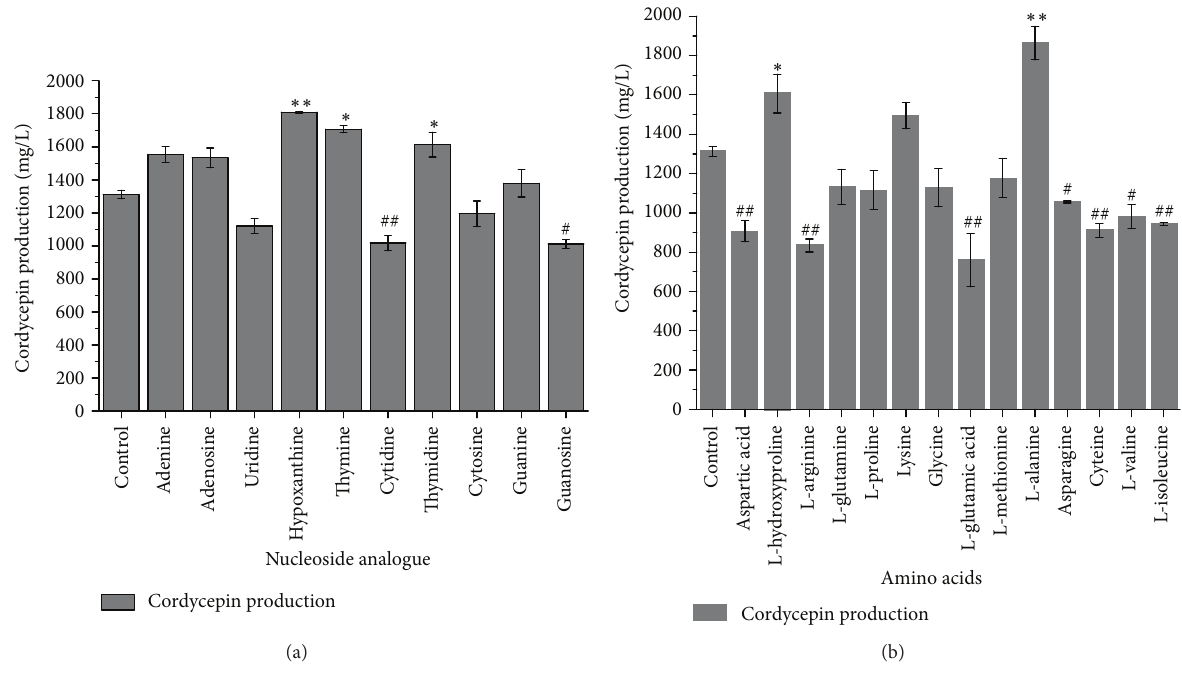
Figure 5: Effects of nucleoside analogue and amino acid on the production of cordycepin: nucleoside analogue (a); amino acid (b); ∗ 5 % significance level (test group versus control group); ∗∗ 1 % significance level (test group versus control group); # 5 % significance level (control group versus test group); ## 1 % significance level (control group versus test